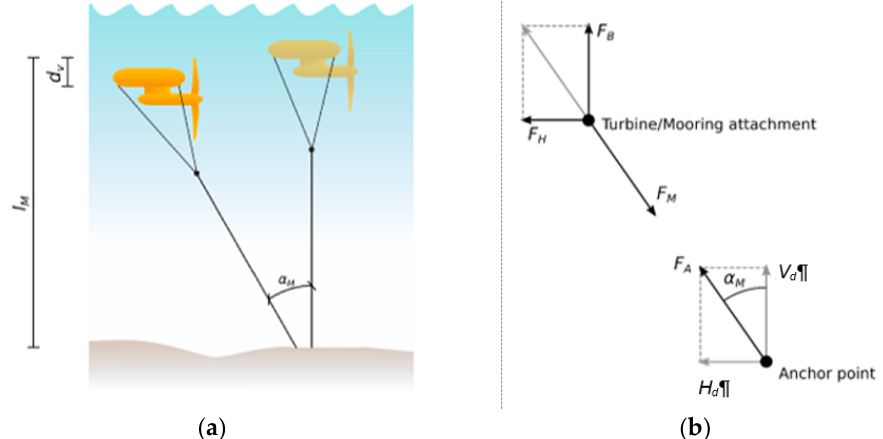
Figure 8. ( a ) Deflection of mooring system under horizontal load. ( b ) Free body diagram of turbine/mooring attachment point and anchor point.